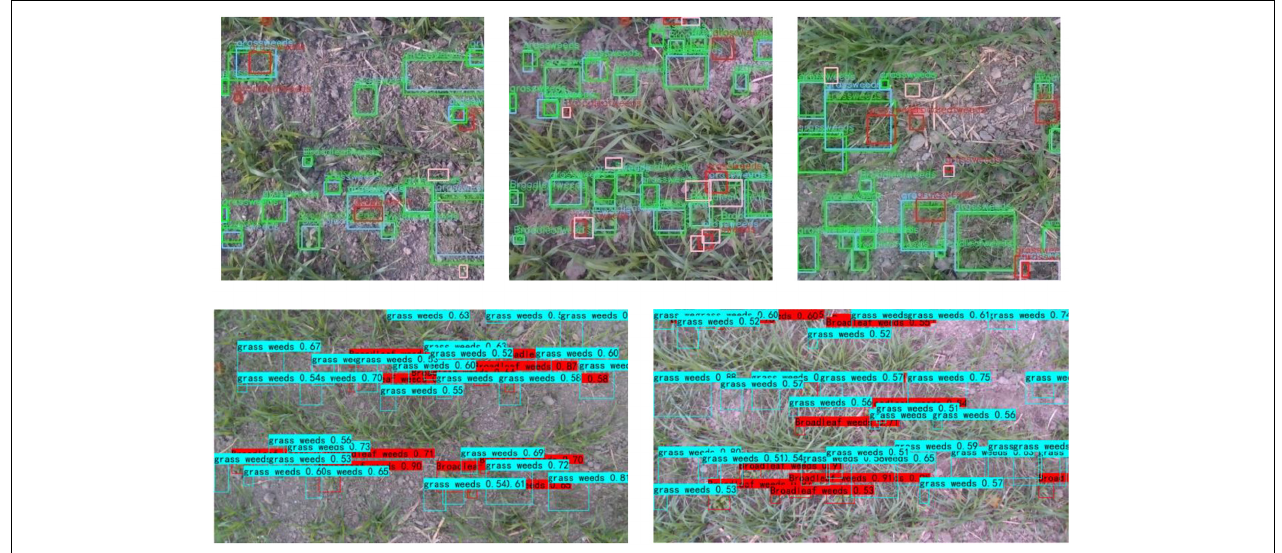
FIGURE 8 | Weeds detection with images of wheat fields. The three graphs in the first row show the detection results of the test set, where green indicates true positive cases, blue indicates corresponding labeling results, pink indicates false negative cases, and red indicates false positive cases. The two graphs in the second row show the detection results of our method on images outside the